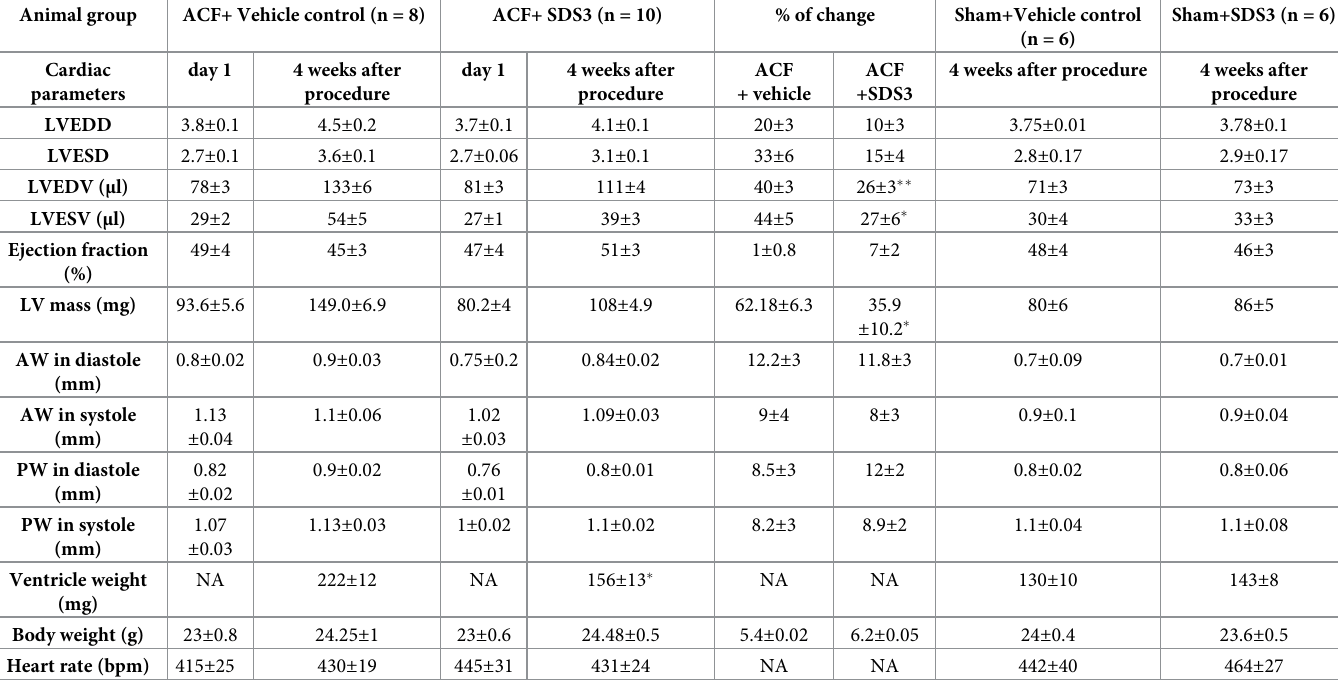
Table 1. SDS3 attenuates ACF-mediated cardiac dilation with no toxic effects on sham-operated controls. Animal